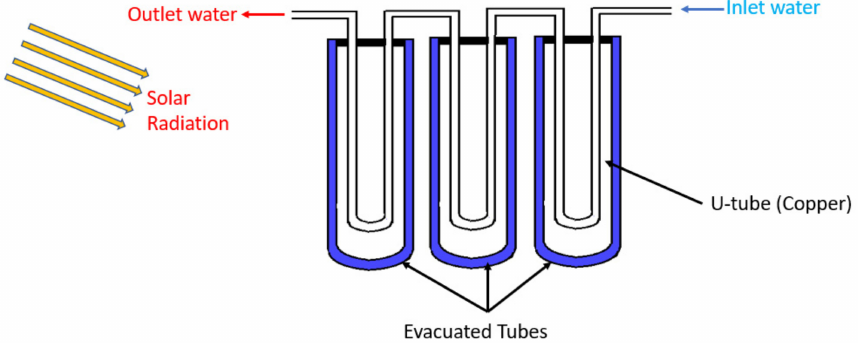
Figure 4. U-tube-type evacuated tube solar water